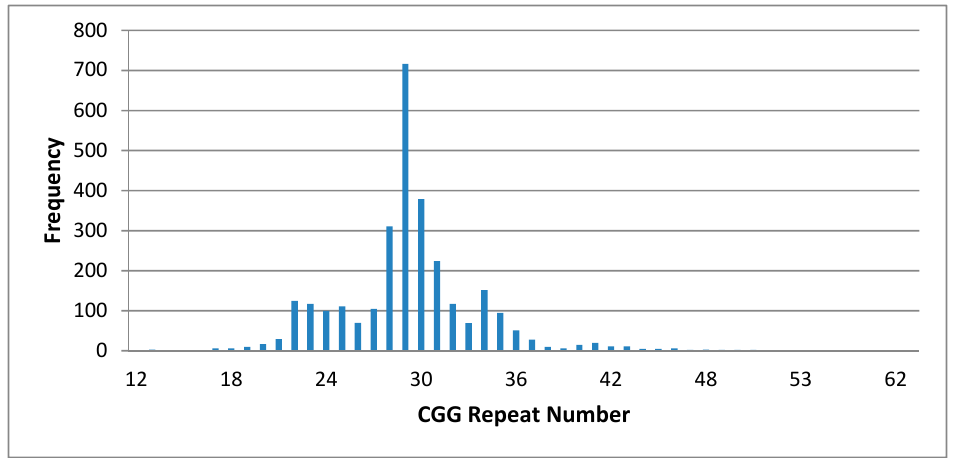
Figure 2. Distribution of CGG repeat sizes obtained from the standard fragile X